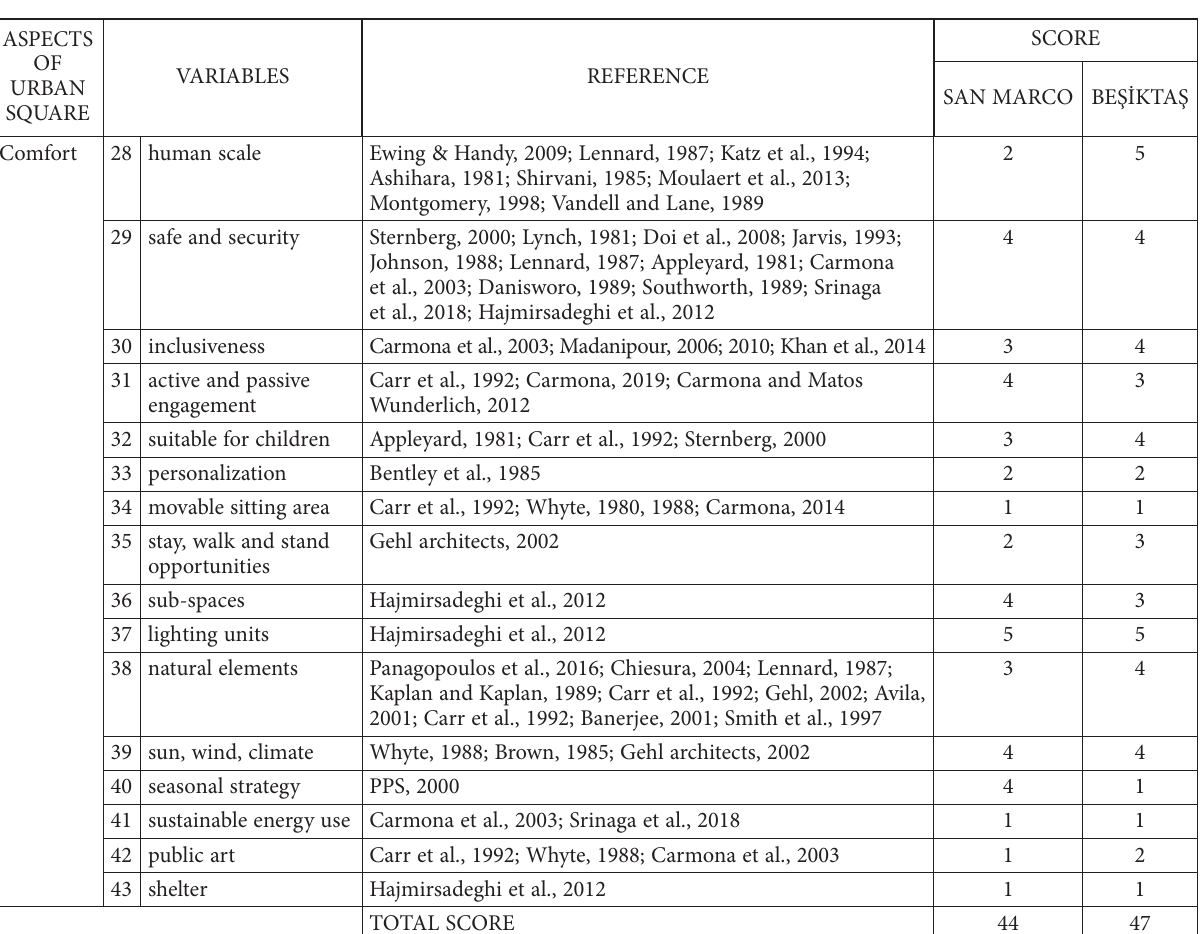
Table 4. Comfort quality